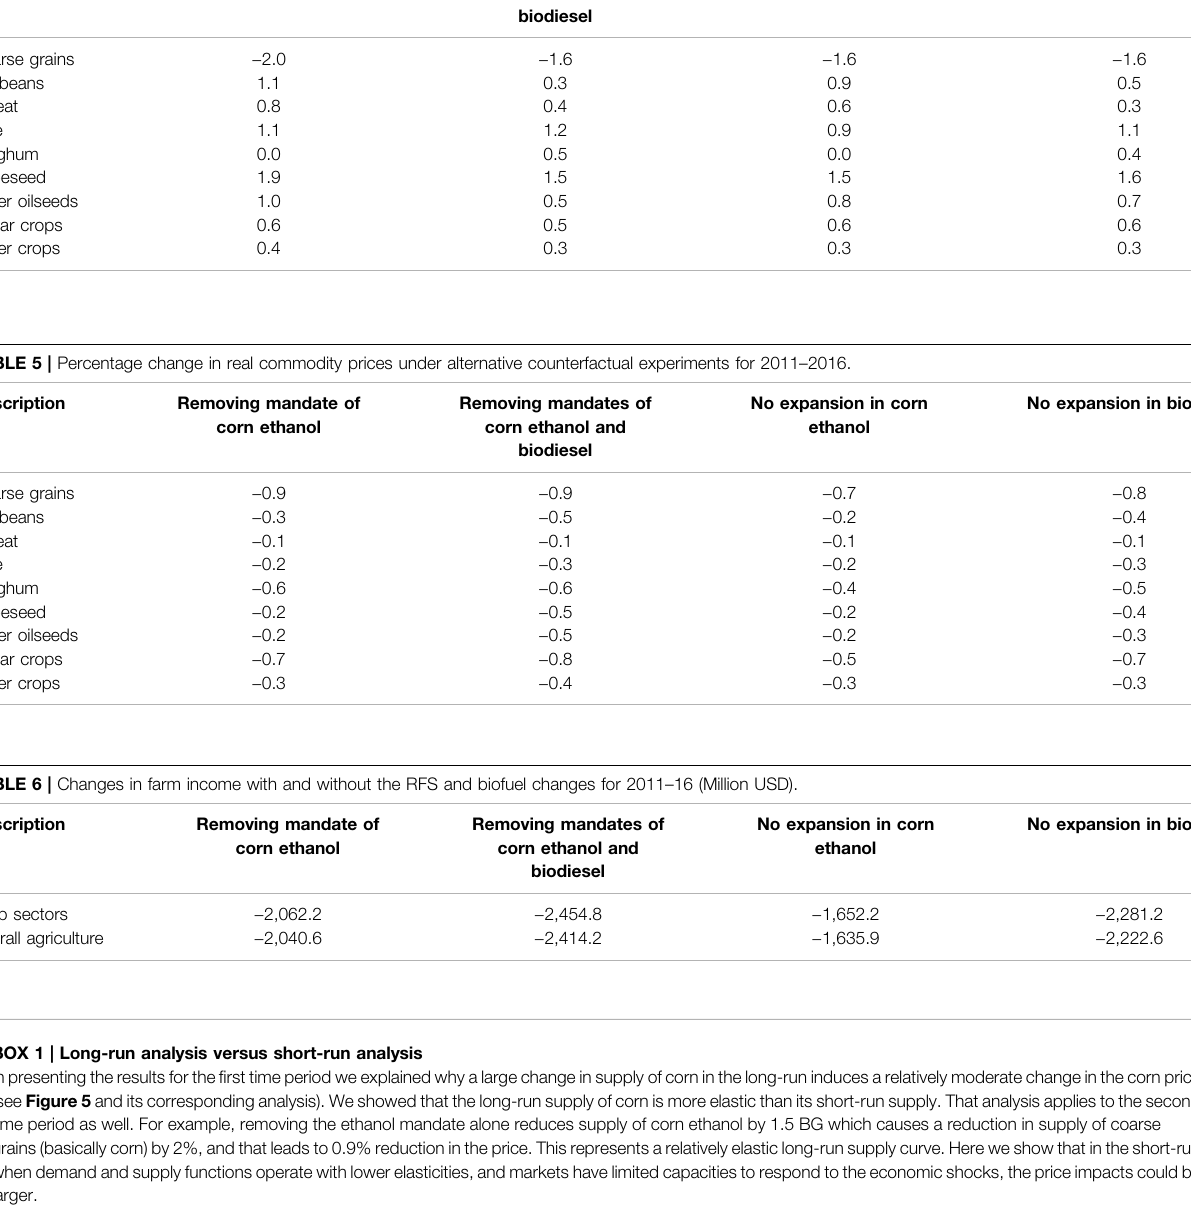
TABLE 4 | Percentage change in crop outputs under alternative examined counterfactual experiments for 2011 – 2016. Description